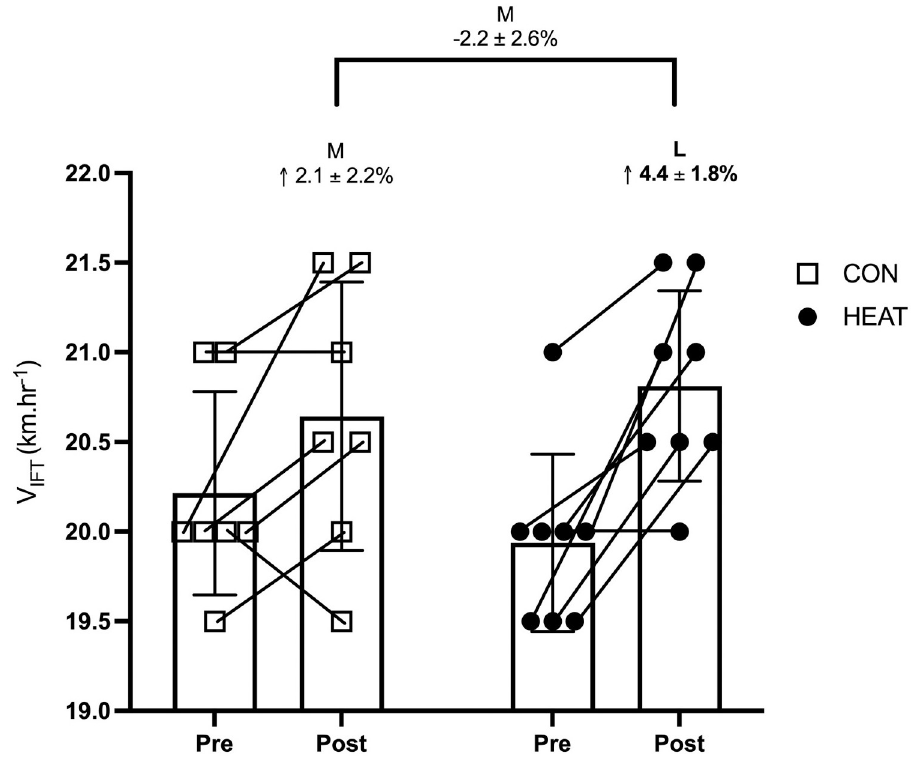
Fig 3. Mean ± SD 30–15 intermittent test (V IFT ) final velocity pre- and post-intervention in HEAT and CON. Within-group changes are indicated above the respective post-value and above those is the between-group comparison of change. All comparisons are expressed as mean ± 90% confidence intervals. Letters depict effect size (d); L (large), M (moderate), with bold utlised to express clear